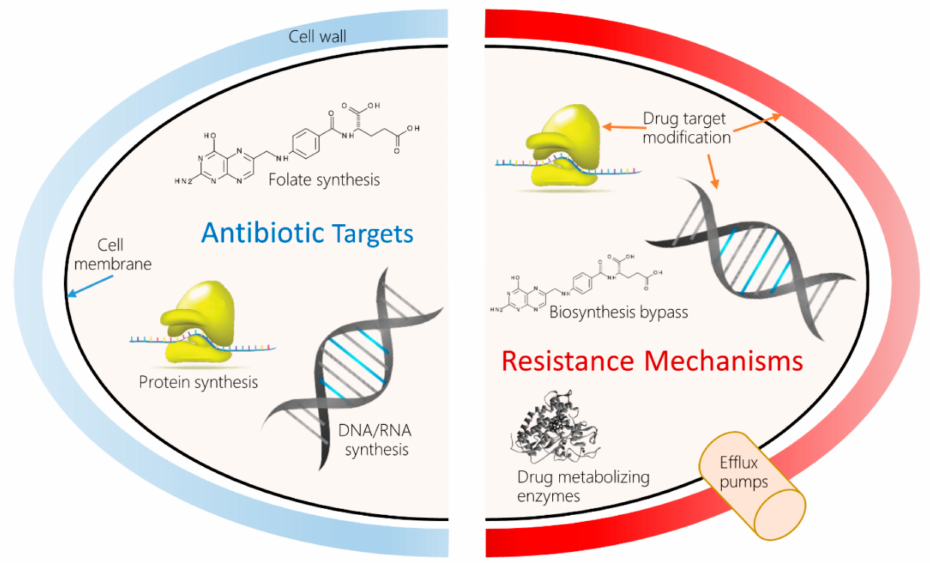
Figure 1. Antimicrobial drug targets and molecular mechanisms of antimicrobial resistance (AMR). Left: The most common classes of AB currently in use impede bacterial growth by inhibiting the biosynthesis of peptidoglycan, a main constituent of cell wall; disrupting the bacterial cell membrane; and inhibiting DNA replication, gene transcription and translation, and folate biosynthesis. Right: In turn, bacteria have developed many resistance mechanisms to these attacks, such as pumping the AB out of the cell, inactivating the drug using specialized enzymes, modifying the target structures to prevent interference, and bypassing the a ff ected metabolic